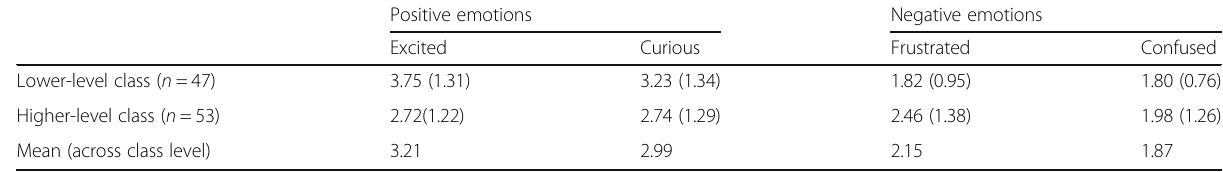
Table 2 Achievement emotion scores across time points and grade levels Positive emotions Negative emotions Excited Curious Frustrated